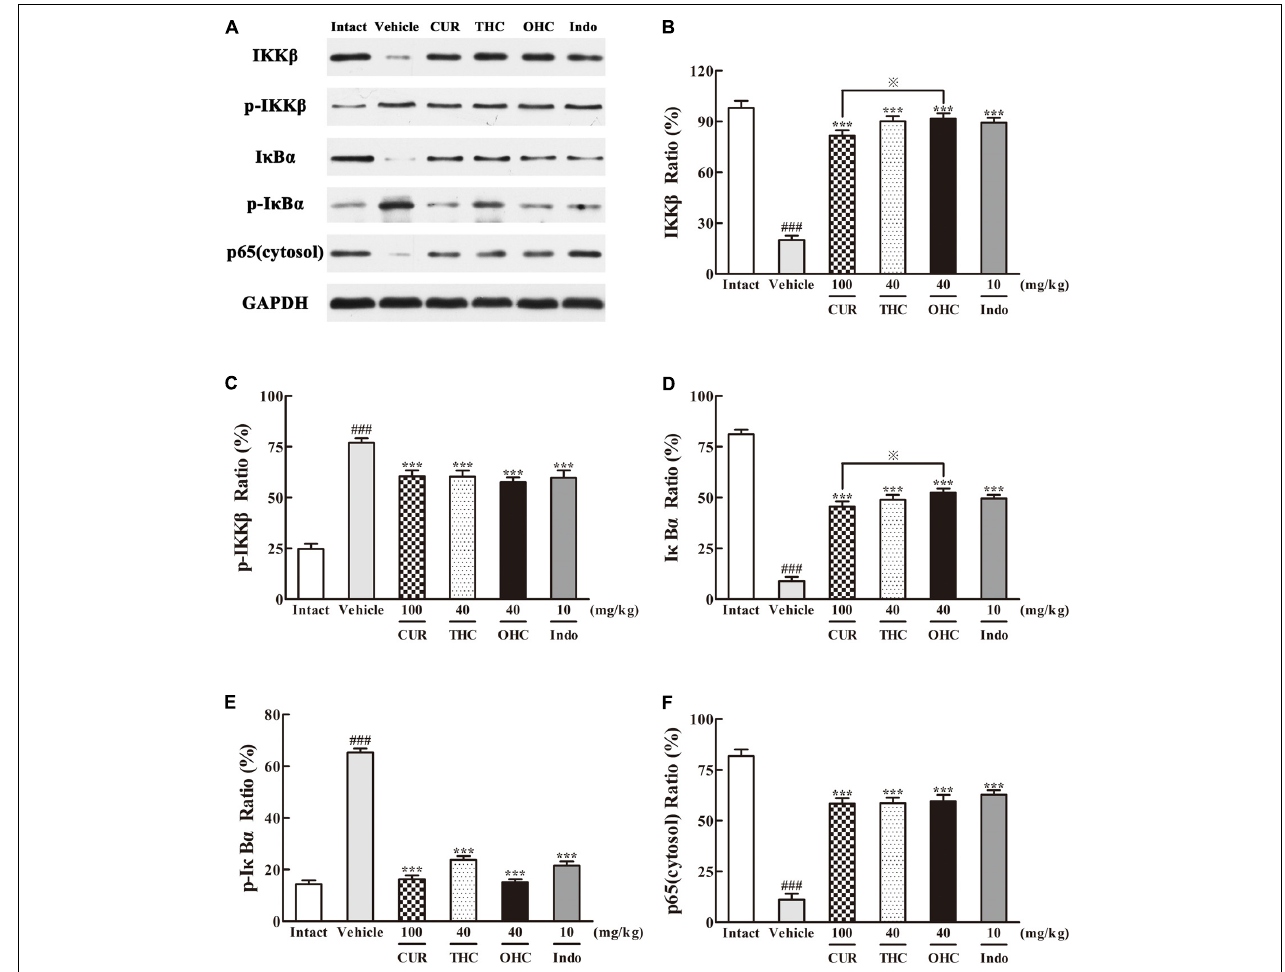
FIGURE 7 | Effects of (A) Representative lanes of IKK β , p-IKK β , I κ B α , p-I κ B α and p65 (cytosol). THC and OHC on IKK β (B) , p-IKK β (C) , I κ B α (D) , p-I κ B α (E) , and p65 (cytosol) (F) protein expressions in the carrageenan-induced mouse paw edema. After administration with THC (40 mg/kg, i.g.), OHC (40 mg/kg, i.g.) or CUR (100 mg/kg, i.g.) for 7 days, the hind paws were removed and homogenized in the lysis buffer, and then the protein extracts of hind paws were transferred to polyvinyl difluoride (PVDF) membranes and analyzed by Western blot. GAPDH was employed as loading control. Data were expressed as means ± S.E.M. ( n = 3), ### p < 0.001 vs. the intact control; ∗∗∗ p < 0.001 vs. the vehicle control; ※ p < 0.001 vs. the CUR group. Significant differences between groups were determined by ANOVA and Dunnett’s post hoc